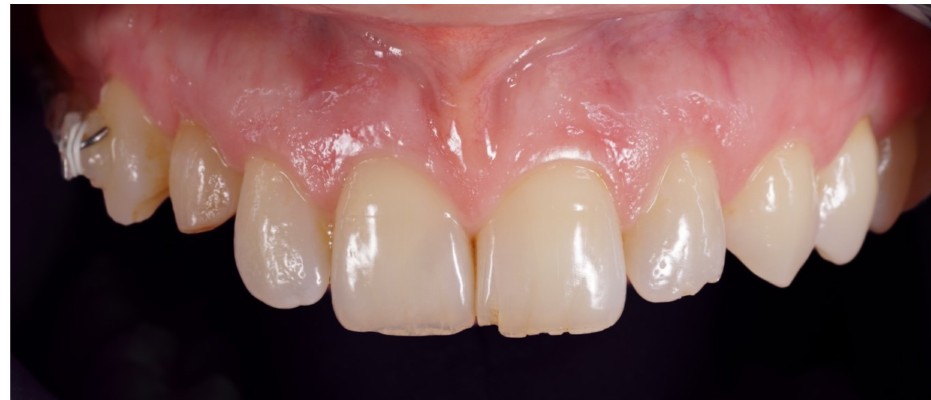
Figure 1. Preoperative frontal view.